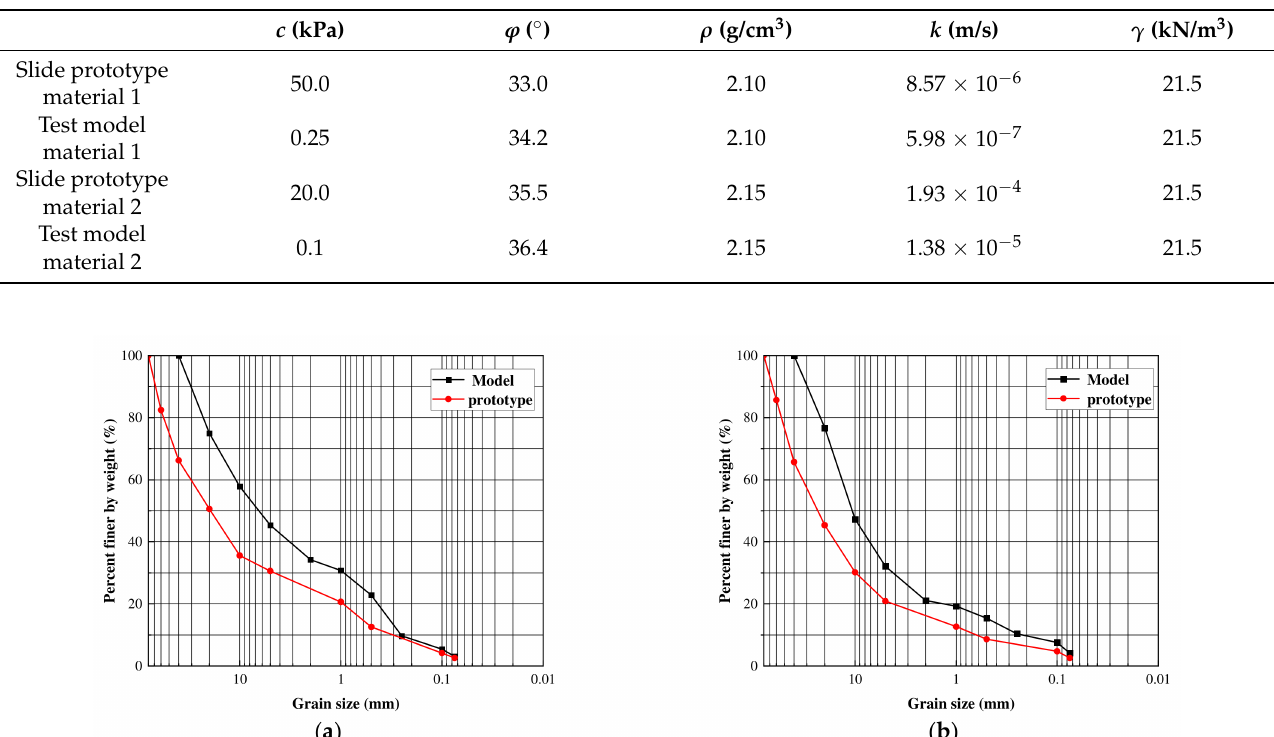
Table 1. Physical and mechanical parameters of the experimental model.